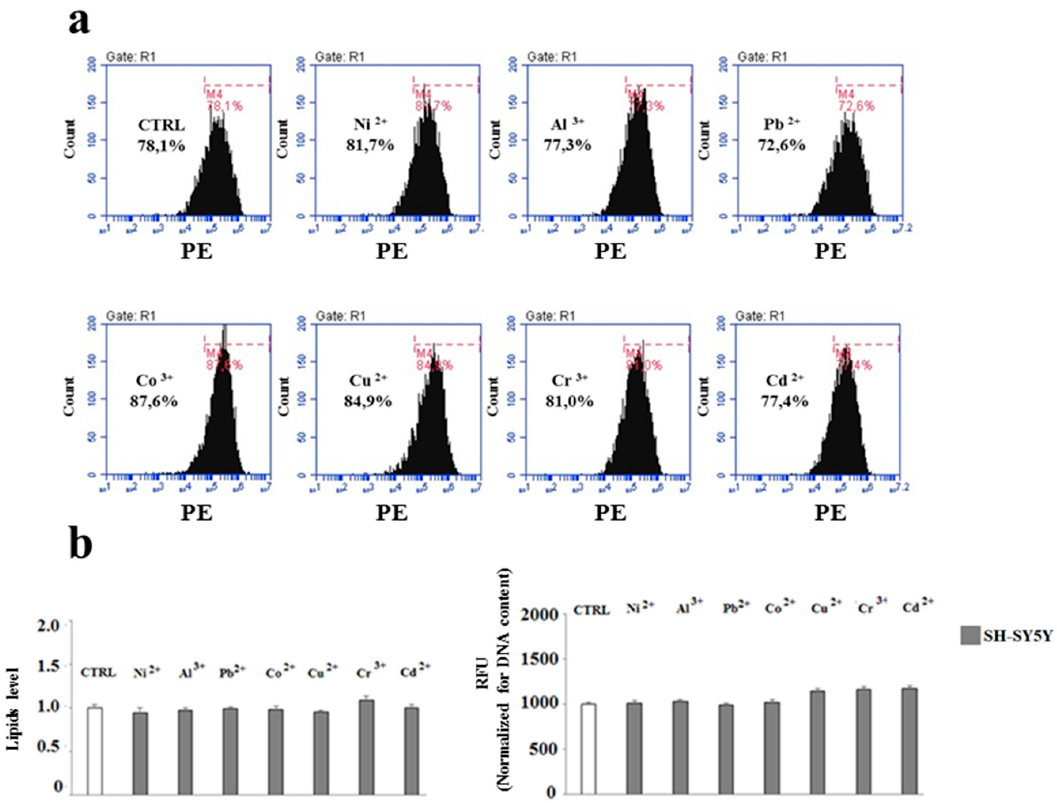
Figure 6. Neuron lipid quantification through flow cytometric and spectrophotometric analysis. Differentiated human oligodendrocytes and human neurons were grown separately and treated with heavy metals for 24 h. At the end of the treatment, the cells were picked up and incubated at 37 °C with Nile Red and analysed with the FACS Accury flow cytometer. For the purposes of the spectrometric assessment of lipids, the cells, after the treatment with heavy metals and incubation with Nile Red colouring agent, were picked up and lipids were extracted through the Bligh & Dyer method. Then, the lipid content relating to each sample was subjected to spectrometric reading. Panel ( a ) denotes the plots relating to the flow cytometric reading of neurons with the corresponding marker which shows the absence of a shift of the peaks to the right or left. Panel ( b ) on the left indicates the quantification of the flow cytometric analysis; on the right, the values obtained through the spectrometric analysis are reported. The values thus obtained were then normalised for the cellular DNA content. Values of three independent experiments are expressed as mean ± standard deviation (sd). No significant differences were detected among different heavy metal treatments. Analysis of Variance (ANOVA) followed by the Tukey-Kramer comparisons test.